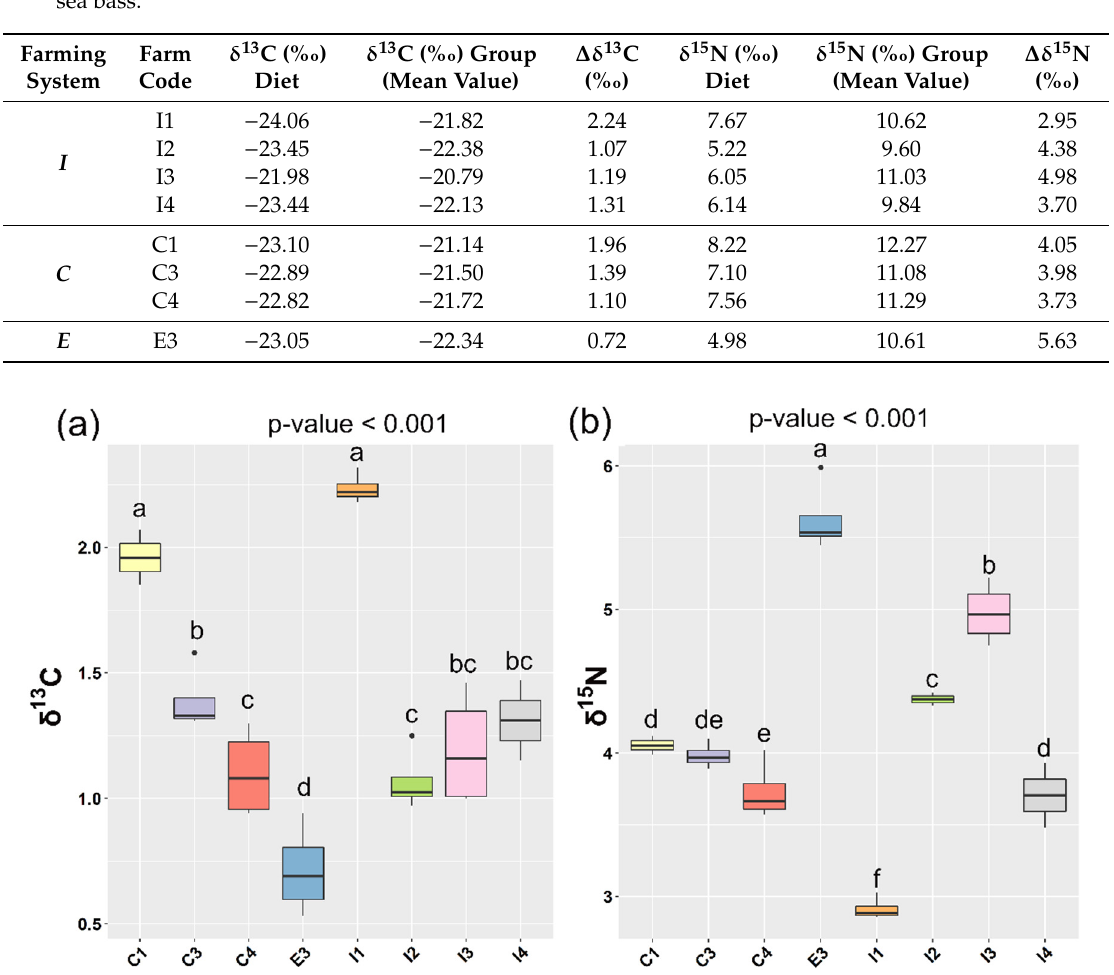
Figure 2. Trophic shift measured for carbon ( a ) and nitrogen ( b ) isotopic ratios between the feed supplied and muscle of sea bass. A one-way ANOVA was performed on the data and the letters above the boxes correspond to the Tukey Honestly Significant Difference (HSD) post hoc test.